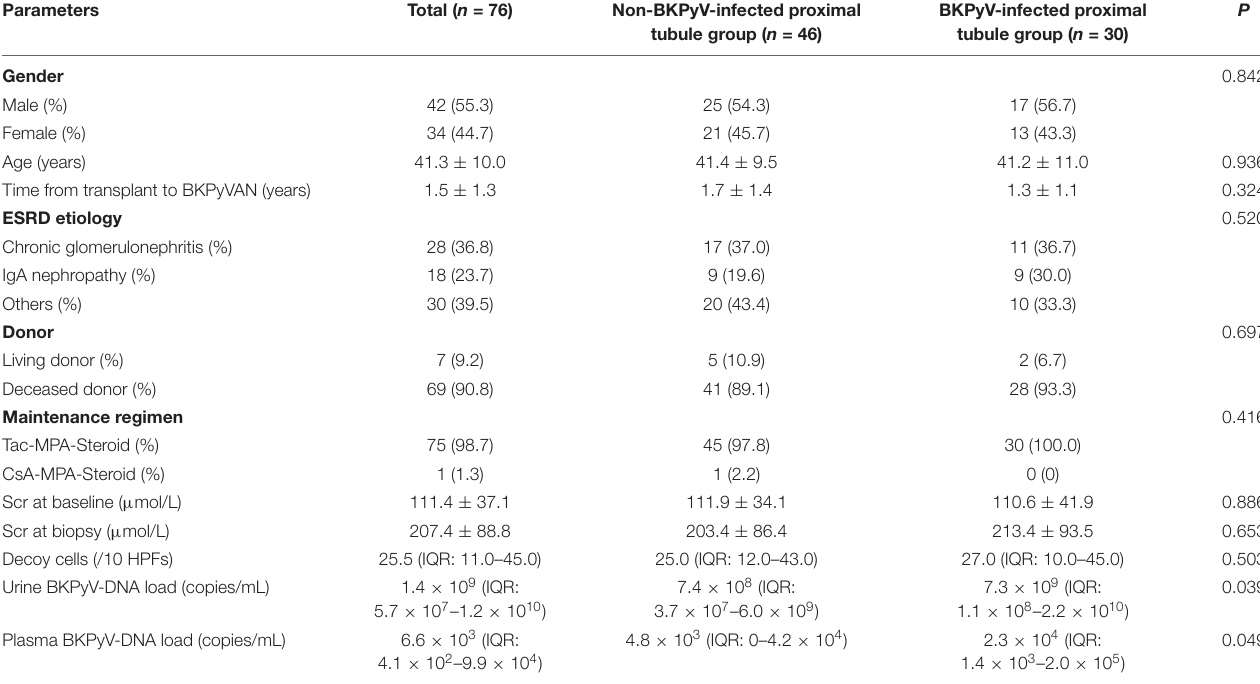
TABLE 1 | Demographics and transplant characteristics of 76 patients with biopsy-proved BKPyVAN. Parameters